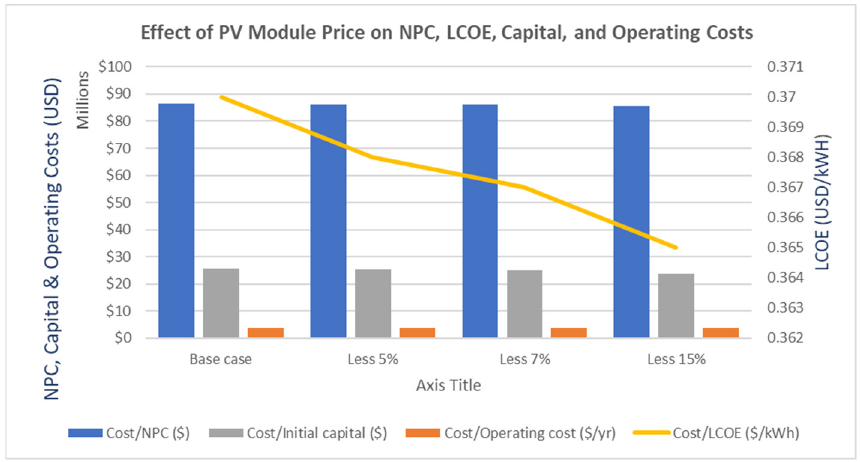
Figure 18. Impact of PV module price decrease on system costs for the PV|WT|DG|BAT model.